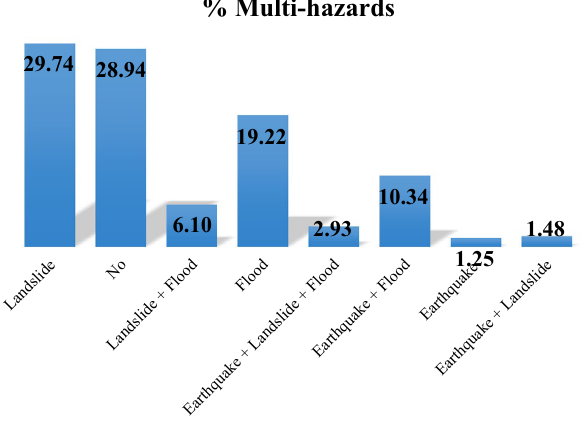
Figure 6. Percentage of areas of hazard